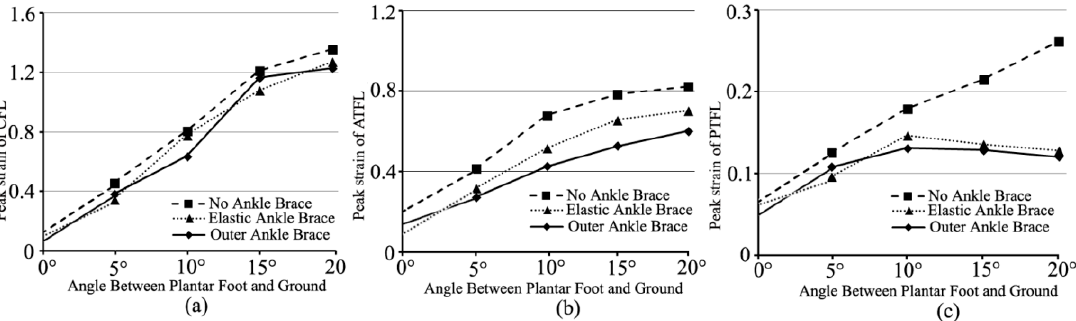
Figure 6. Peak strains of the lateral ankle ligaments during the foot landing on 0° − 20° incline: ( a ) CFL; ( b ) ATFL; and ( c ) PTFL under non-, elastic-, and external-ankle-brace conditions.